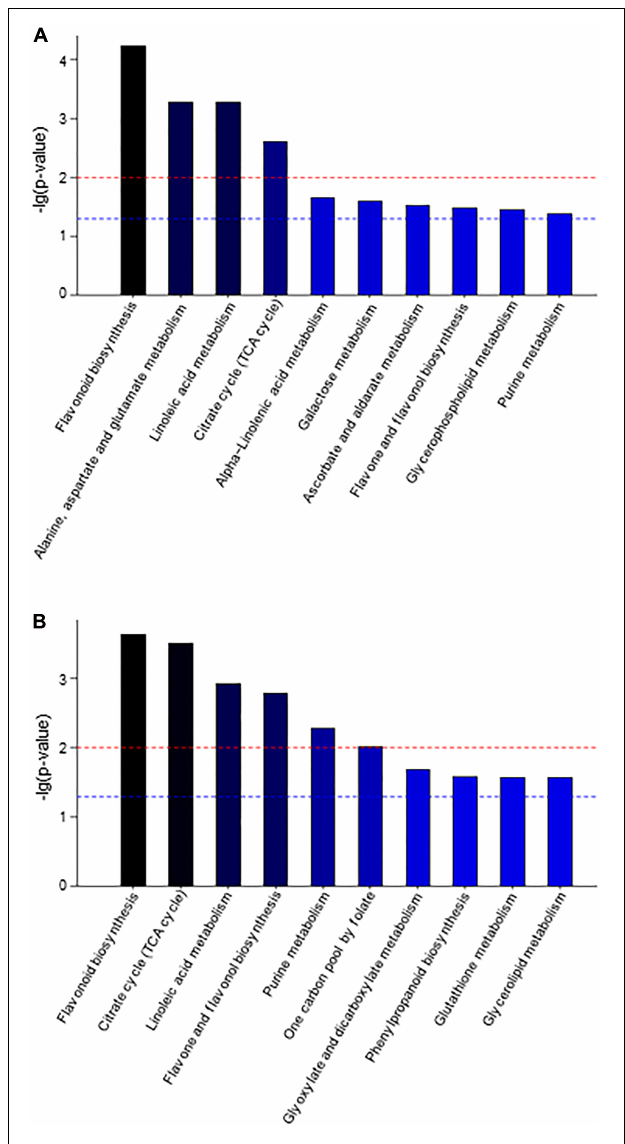
FIGURE 3 | The KEGG pathway enrichment analysis of differential metabolites between sample AP3 versus sample AP1 (A) and sample AP6 versus sample AP1 (B) . Each comparison mycelia only shows top 10 enrichments pathways of differential metabolites. P -value was calculated using hypergeometric